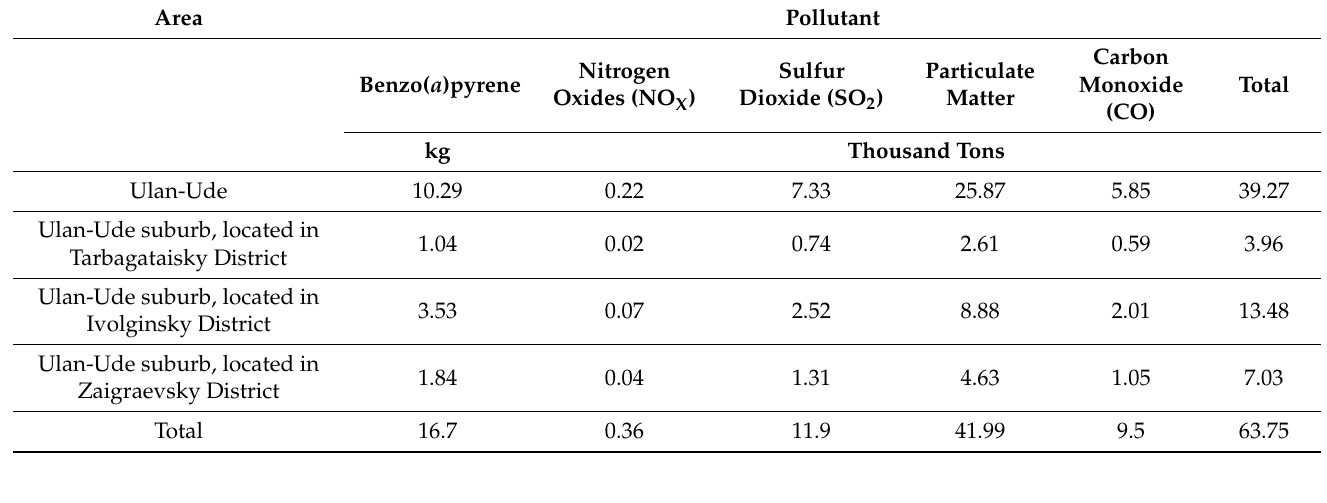
Table 4. Total pollutant emissions from households in Ulan-Ude and its suburbs per year (during the heating season 2020/2021.